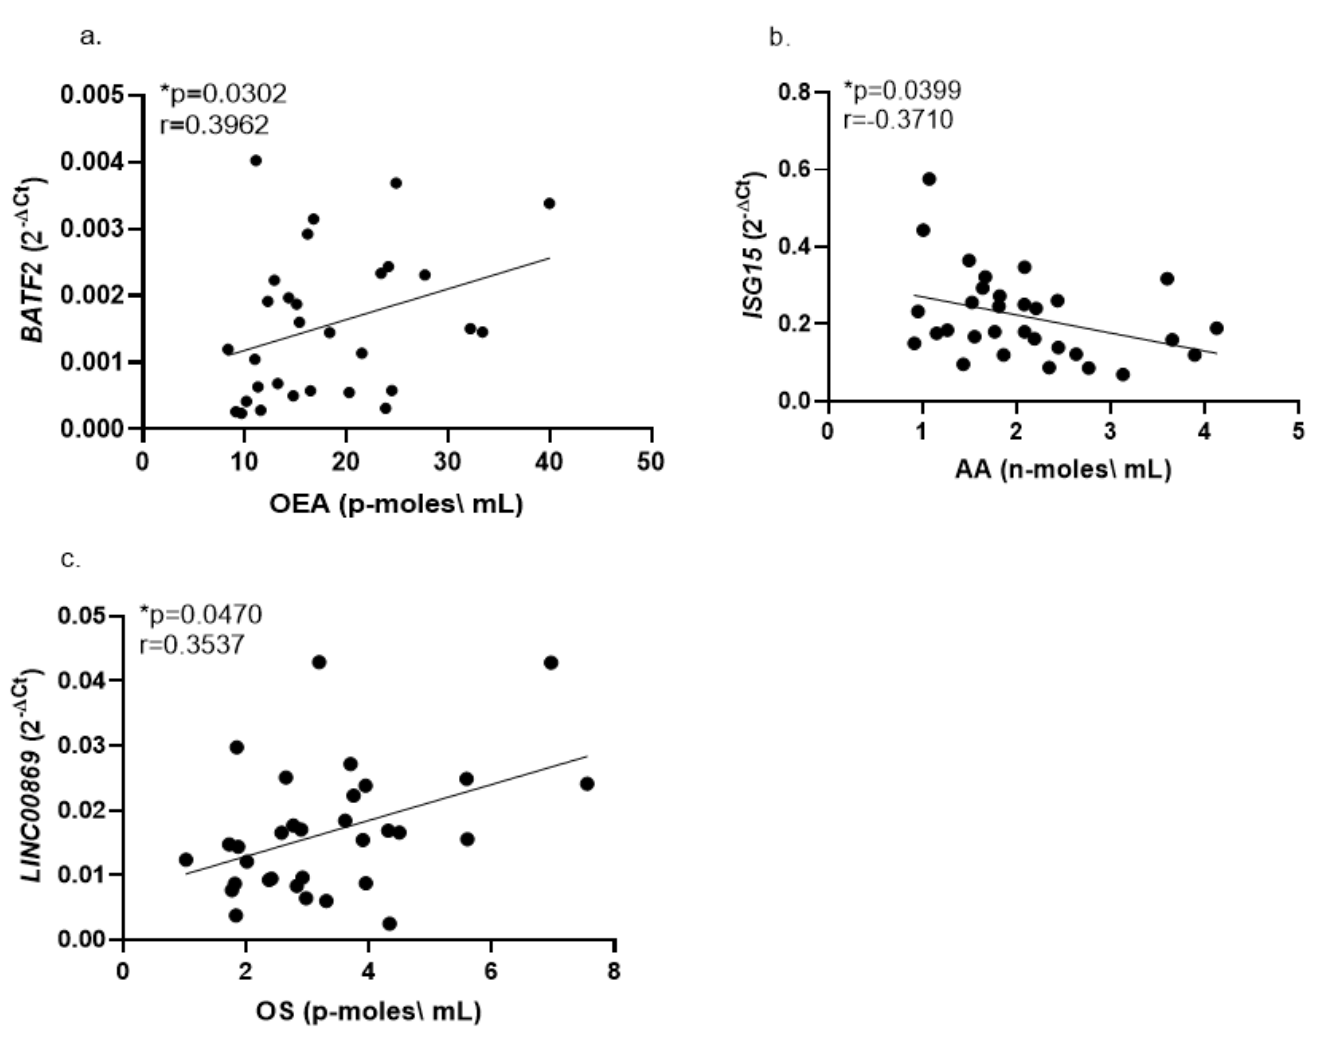
Figure 2. Correlations for whole blood mRNA expression levels with serum endocannabinoid levels in ASD children (Israeli cohort). Correlations are shown for ( a ) BATF2 and oleoylethanolamide (OEA); ( b ) ISG15 and arachidonic acid (AA); ( c ) LINC00869 and Oleoyl serine (OS). The r and p values for each correlation plot (Spearman test) are shown in each panel. Endocannabinoid levels are from Aran et al., 2019 [18]. * p < 0.05. See Section 4 for further details.